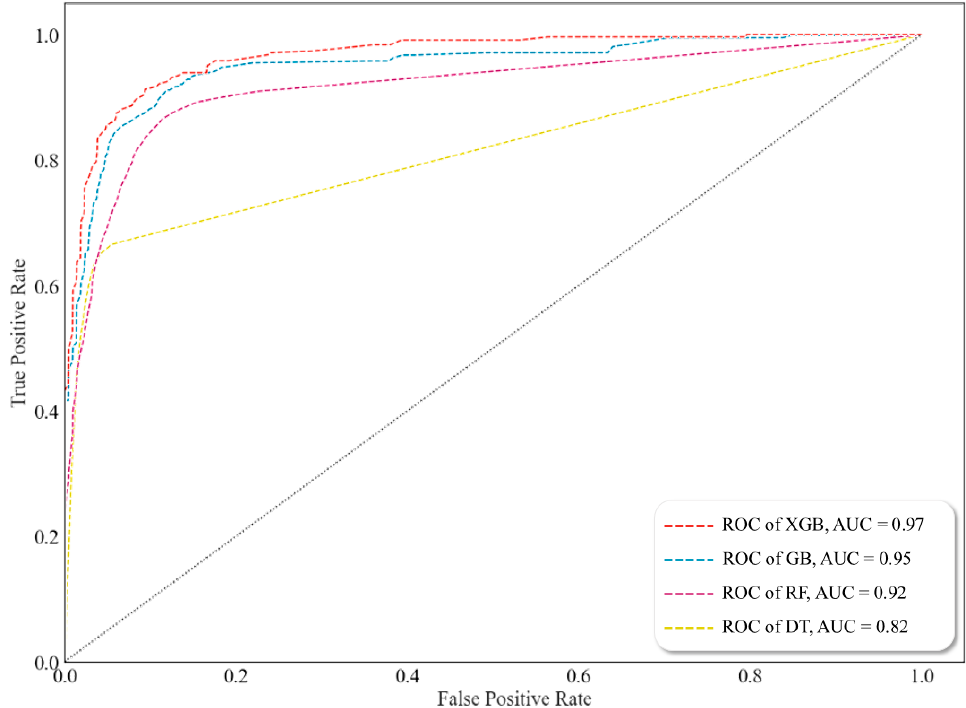
Figure 8. Accuracy evaluation for each machine learning algorithm using receiver operating characteristic (ROC) curve and area under the curve (AUC) .